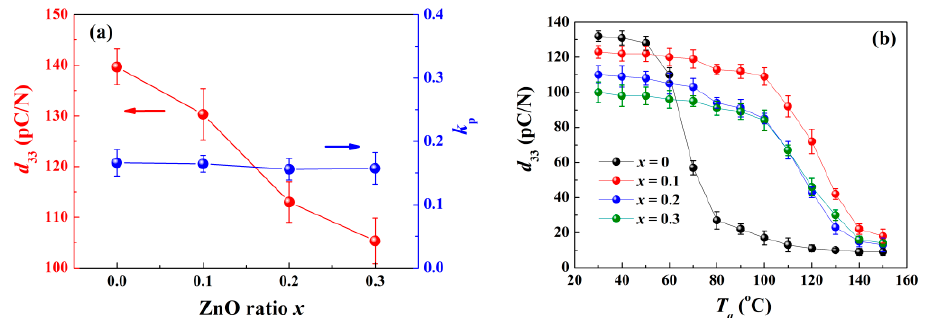
Figure 9. ( a ) Piezoelectric constant d 33 and planar electromechanical coupling factor k p as a function of ZnO ratio x , ( b ) remaining d 33 as a function of annealing temperature T a for all the components.